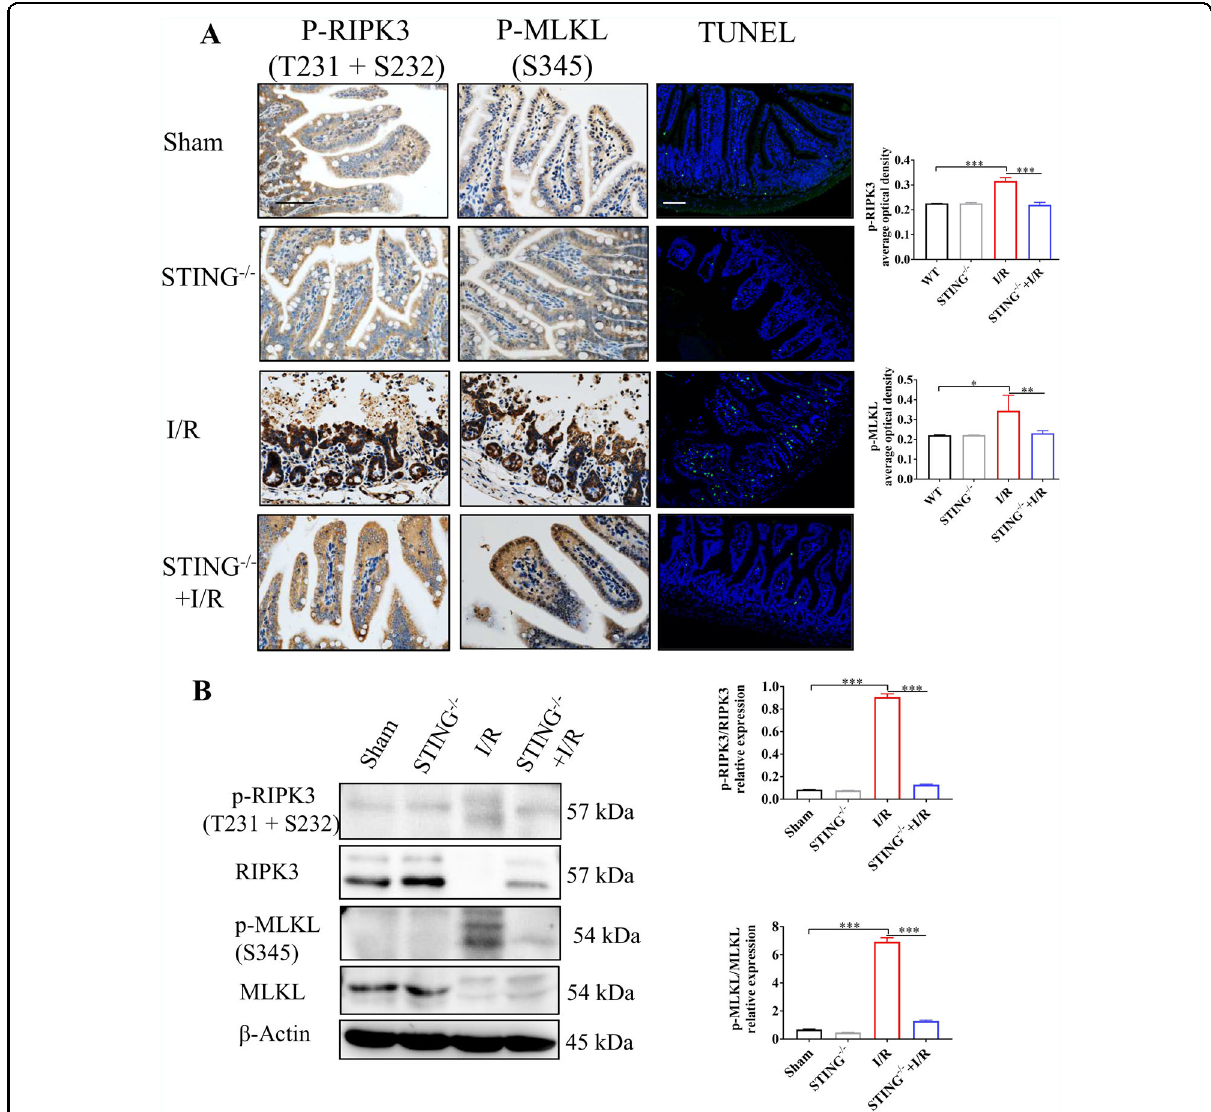
Fig. 6 STING knockout attenuates intestinal necroptosis. ( A – C ) IHC analysis of p-RIPK3 and p-MLKL in wild-type mice and STING knockout mice following intestinal I/R. TUNEL staining was used to analyze cell death. Image J was used to detect the optical density of p-RIPK3 and p-MLKL in immunohistochemistry. ( B ) Necroptosis signaling was detected by western blot. Scale bars = 50 μ m. Data were shown as the mean ± SD. * P < 0.05, ** P < 0.01, *** P <